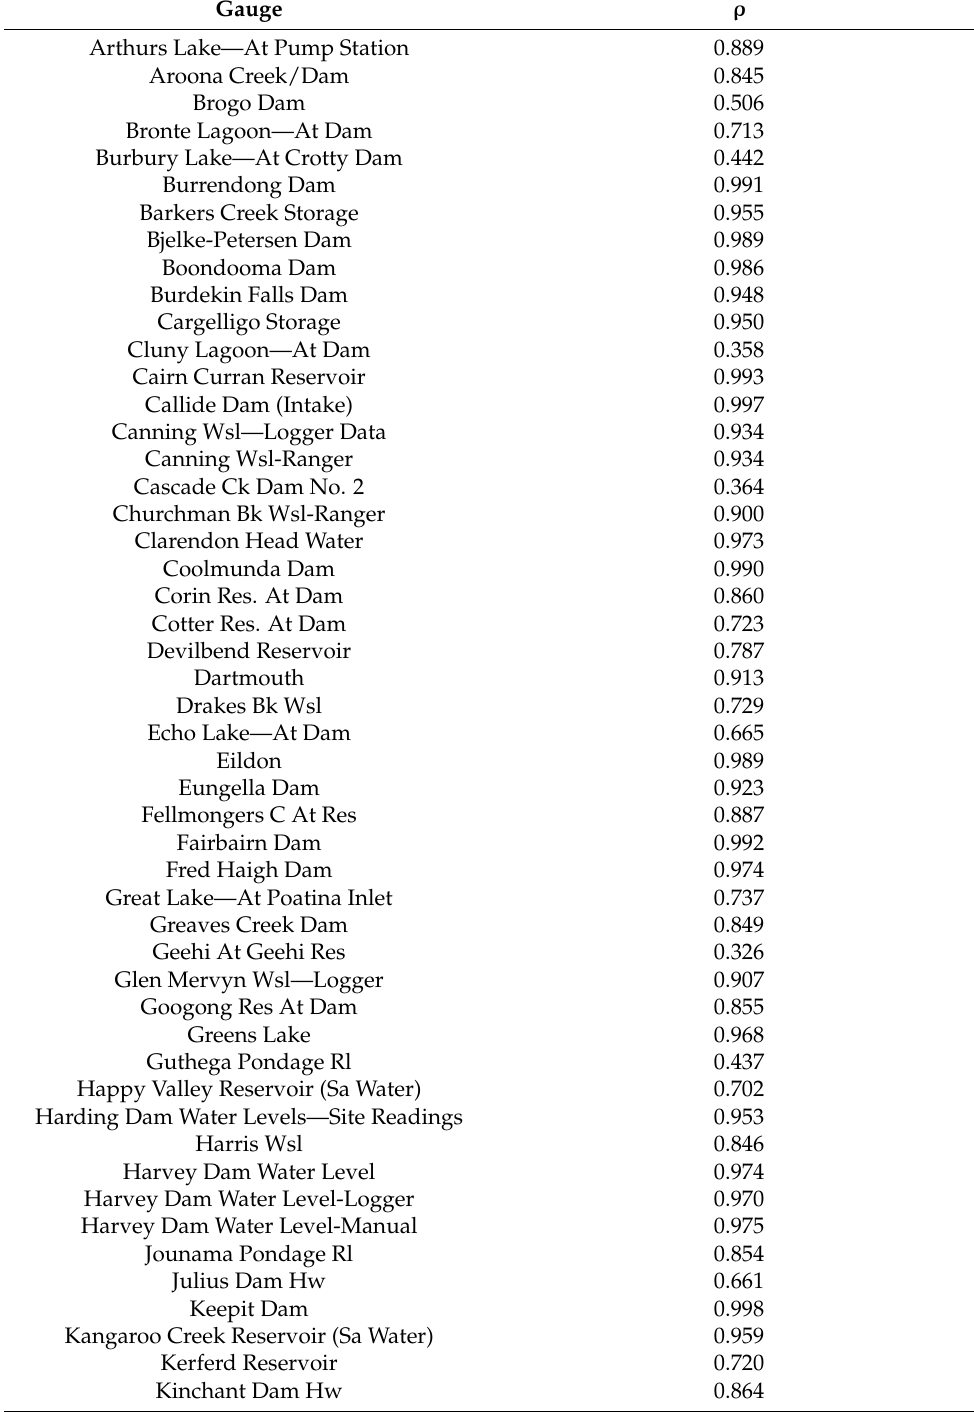
Table A1. Storage gauges and the ρ values from comparing their time series to DEA